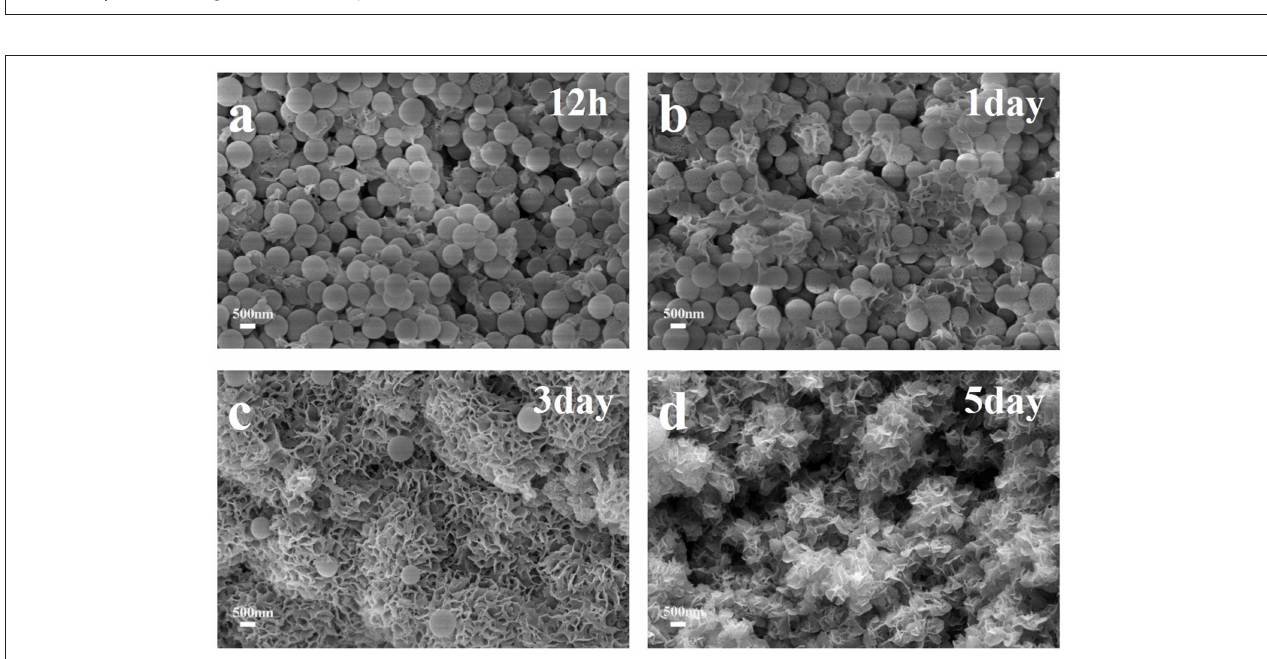
FIGURE 5 | SEM micrographs of HMBG after soaking in SBF for 12h (a) , 1d (b) , 3d (c) and 5d (d) .